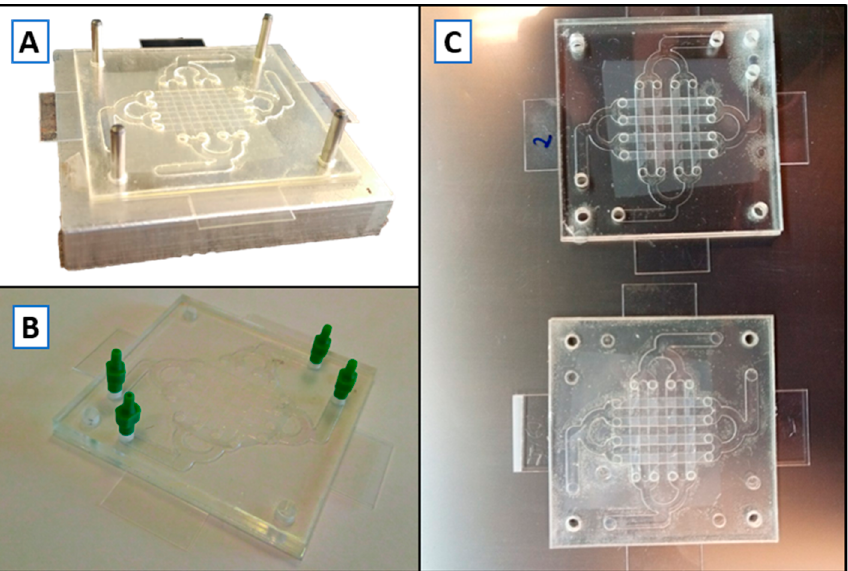
Figure 3. Organ-on-a-Chip (OoC) device assembly. ( A ) OoC in the alignment block during the assembly process; ( B ) Final OoC device assembled with green Mini-Luer ® connectors; ( C ) Optical clarity comparison between ARSeal 8026 PSA (top) and 467 MP (bottom).